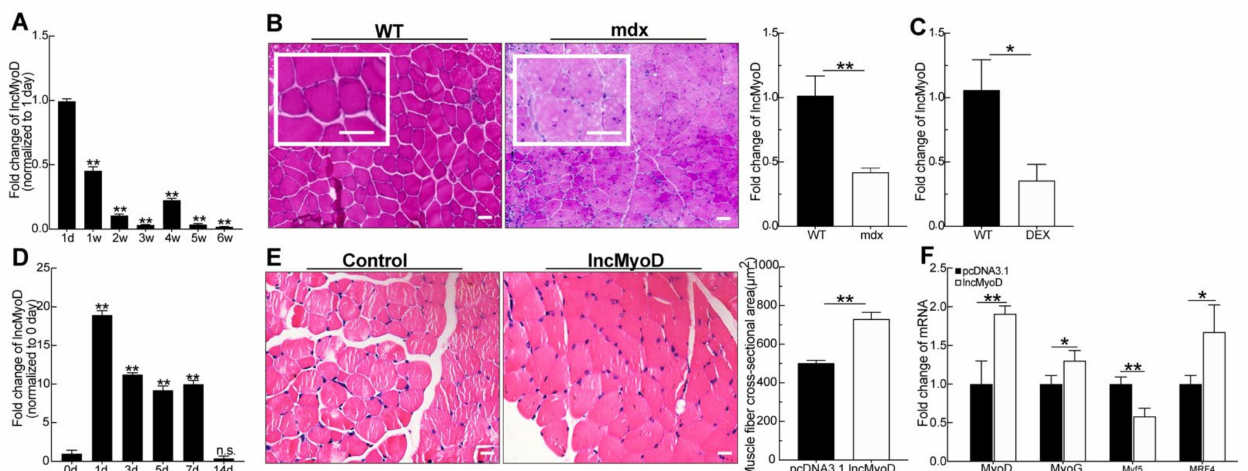
Figure 1. lncMyoD is a novel long-noncoding RNA (lncRNA) associated with myogenesis. ( A ) The expression of lncMyoD in postnatal mice at the indicated ages was detected by qRT-PCR. ( B ) H & E staining of mdx and WT group tibialis anterior (TA) muscle. qRT-PCR measured the expression levels of lncMyoD in C57B/L10ScSn-Dmdmdx/J (mdx) and wild type (WT) mice TA muscle. ( C ) TA muscles were isolated from 8-week-old C57B/L6 mice, which, after being treated with dexamethasone and RNAs, were extracted and used for qRT-PCR assay. ( D ) qRT-PCR measured the expression levels of lncMyoD during CTX-induced muscle regeneration. ( E ) Representative image from H&E staining of mice TA muscle after injection with pcDNA3.1 and lncMyoD vector for 1 month. ( F ) mRNA expression level of MyoD, MyoG, Myf5, and MRF4 in mice TA muscle injected with pcDNA3.1 and lncMyoD vector. Scale bars in (I), 100 µ m and in ( B , E ), 20 µ m in magnified ( B ). All PCR data were normalized to β -actin mRNA and represent means ± SD of three independent experiments. Data are means ± SD. p -values are obtained from independent-samples t -tests. * p < 0.05, ** p <